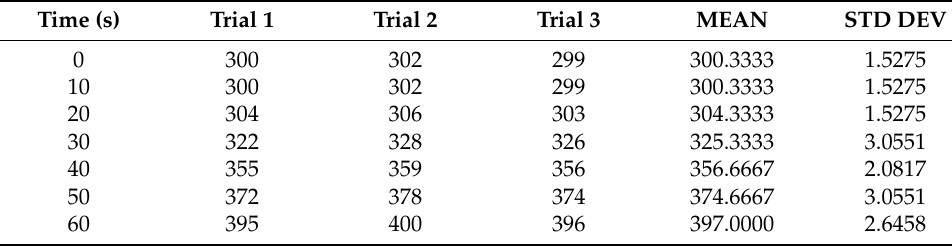
Table A2. Experimental data on FPCB surface temperature (K) in Figure 2.